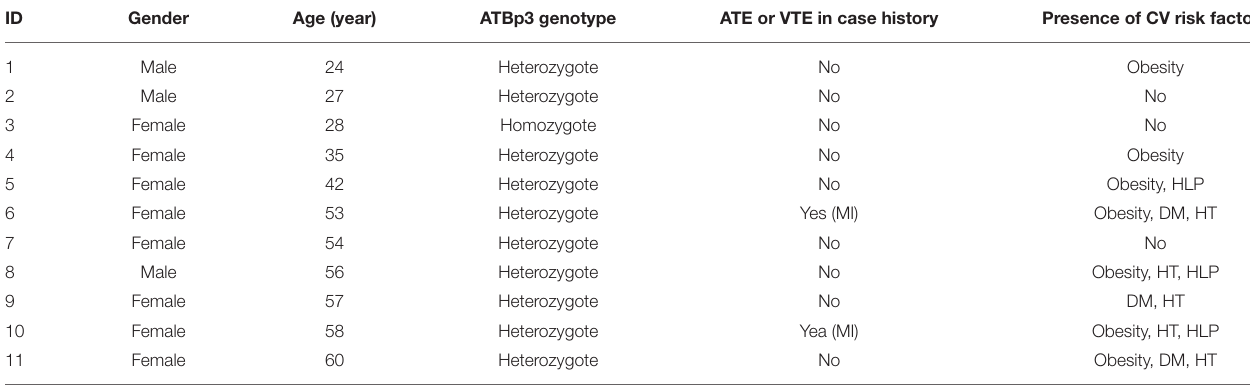
TABLE 2 | Demographic and clinical data of Roma carriers of antithrombin Budapest 3 collected from the confirmatory study. ID Age (year) ATBp3 genotype ATE or VTE in case history Presence of CV risk factors